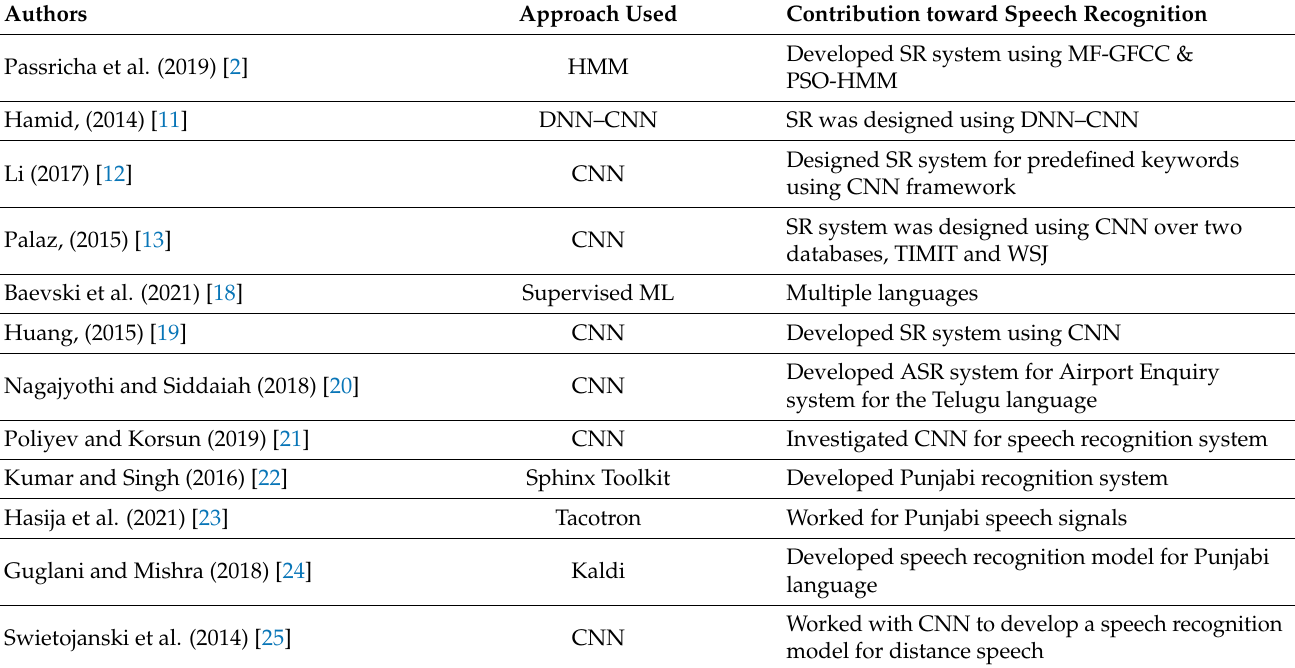
Table 1. Analysis of existing